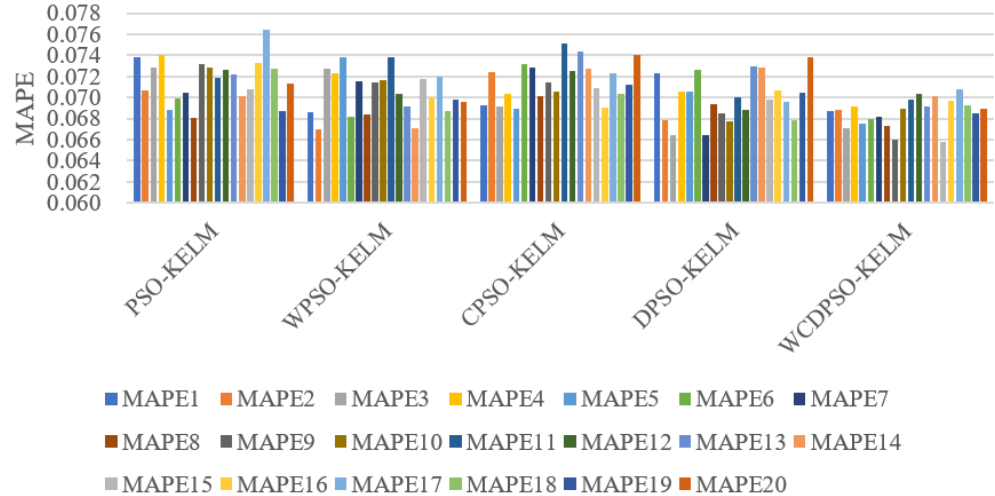
Figure 4. The MAPE value of different models.